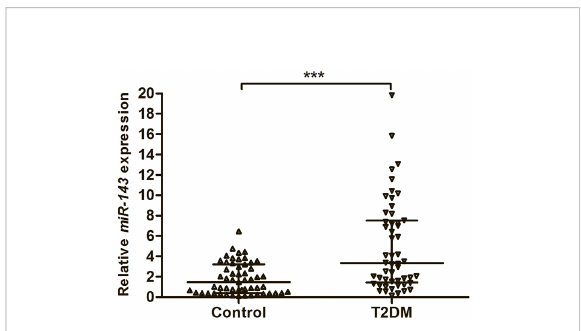
FIGURE 1 The expression levels of miR-143 in the serum from 52 patients with T2DM and 55 healthy subjects. Data were expressed as median with interquartile range, and analysed by Mann – Whitney U test. *** P < 0.001. T2DM, Type 2 diabetes